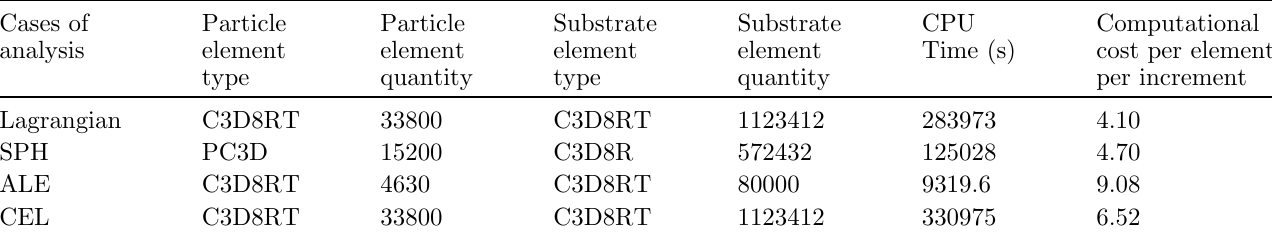
Table 2. Schematic illustration of computational costs by the four numerical modellings. Cases